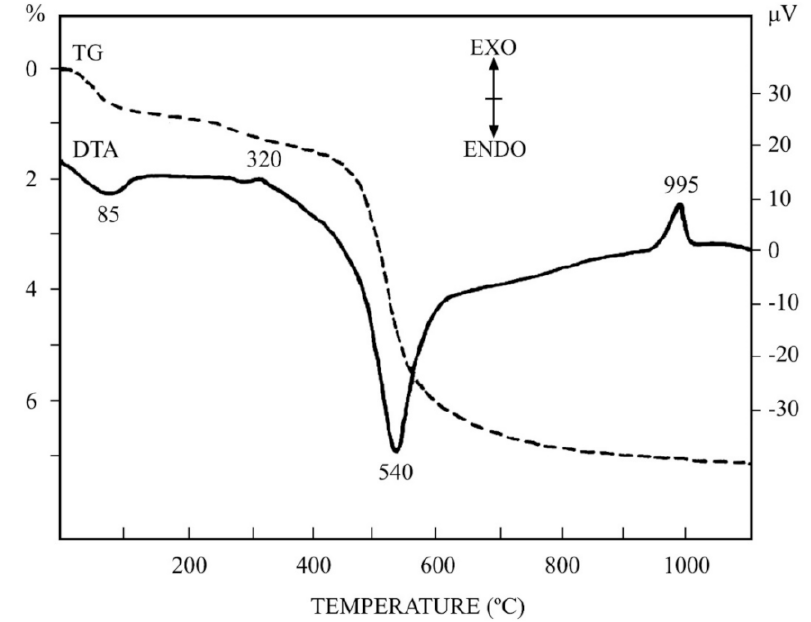
Figure 5. DTA-TG diagrams of the fraction under 63 µ m obtained by wet sieving (heating rate 12 ◦